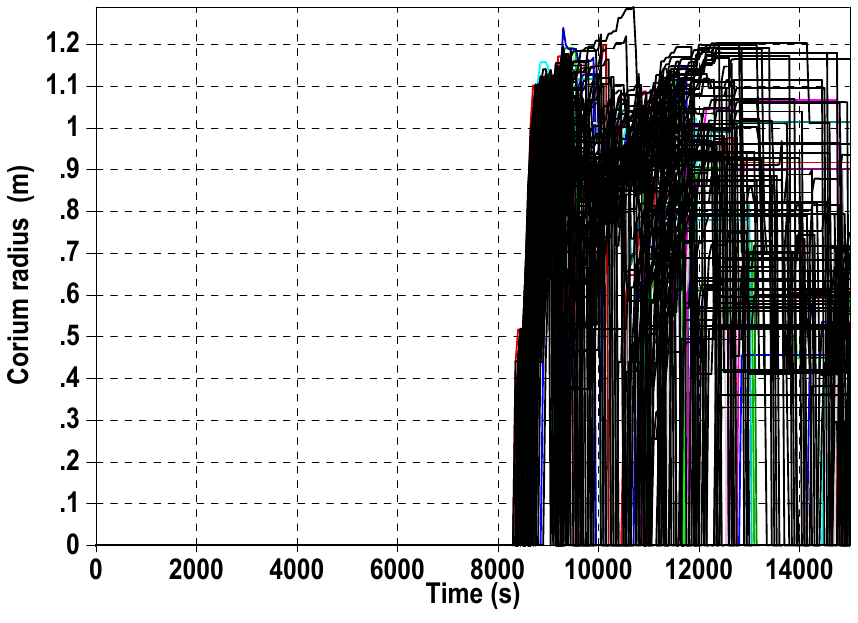
Figure 7. Maximum core temperature.